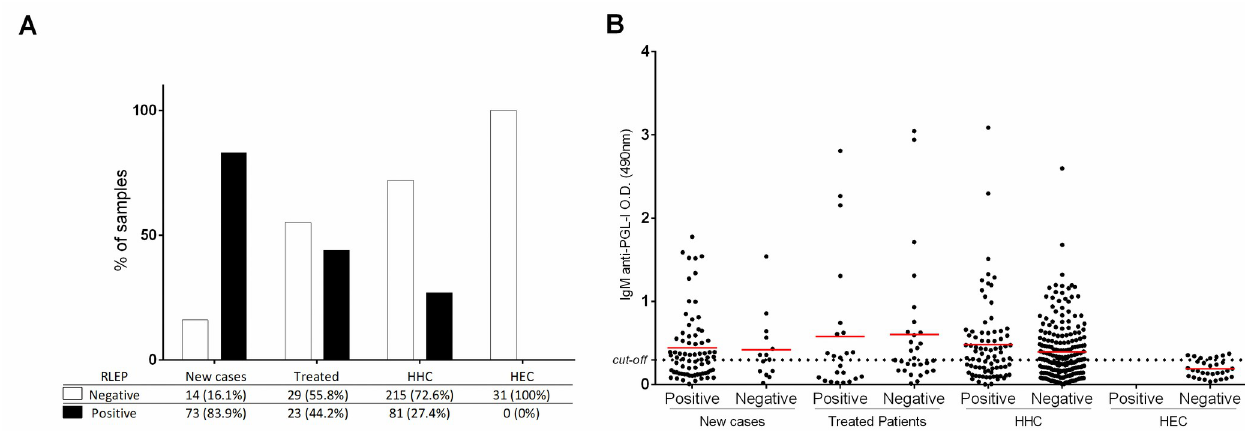
Fig 2. Analysis of RLEP and PGL-I titer for new cases, treated cases, HHC and HEC. A) RLEP positivity within each of the four groups examined based on PCR of earlobe SSS. New cases were 83.9% positive, treated cases were 44.2% positive, HHC were 27.4% positive whereas no HEC were positive (0%). B) anti- PGL-I titer was plotted for each individual based on being RLEP positive or negative within each group. Solid line indicates the median O.D. for each group. There was no significant difference between the median anti-PGL-I titer when positive and negative RLEP groups were compared between any of the two patient and HHC